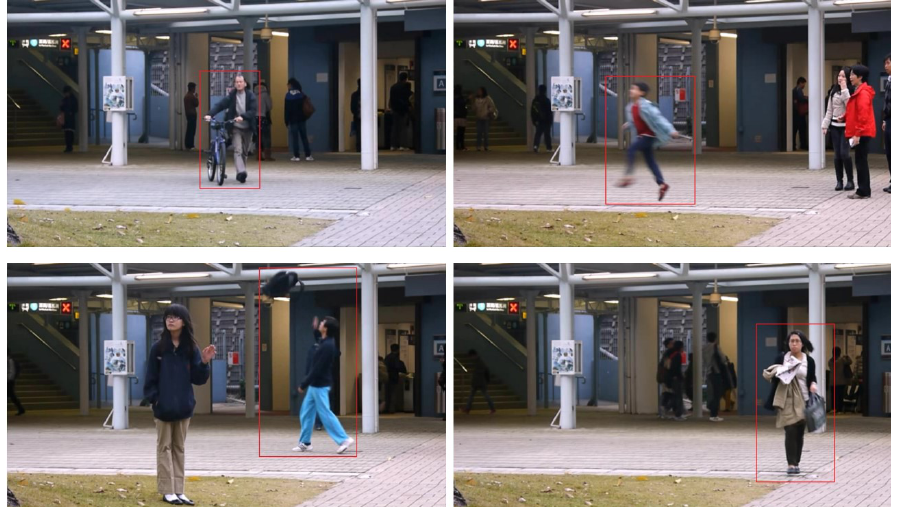
Figure 1. Examples of abnormal frames from the CUHK Avenue dataset are presented.